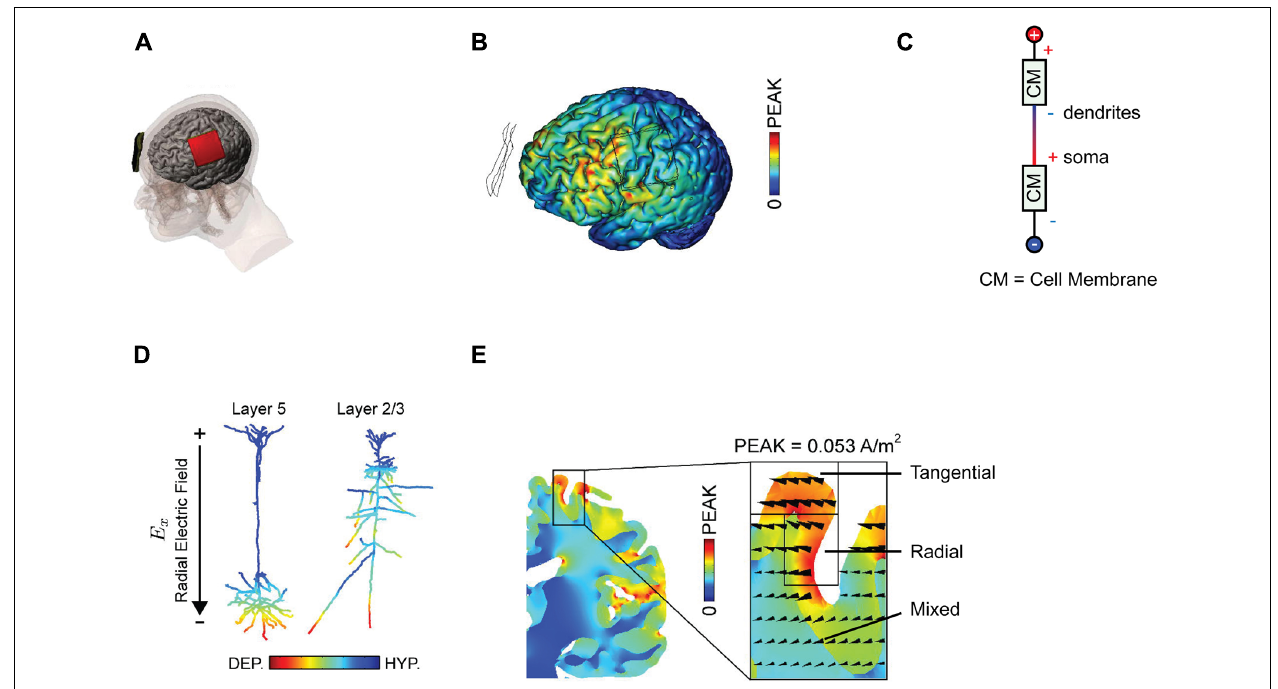
hyperpolarization and depolarization seen in. (D) Superficially depolarizing currents produce hyperpolarization in dendrites and depolarization in the cell soma. (E) The direction of current flow varies considerably within the stimulated area. All figures bar (C) reprinted with permission from Rahman etal.